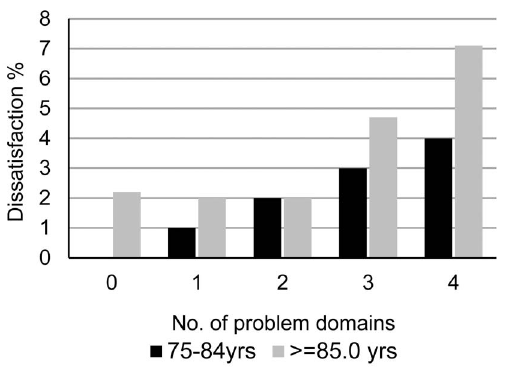
Figure 1. Dissatisfaction in relation to the number of problem domains and